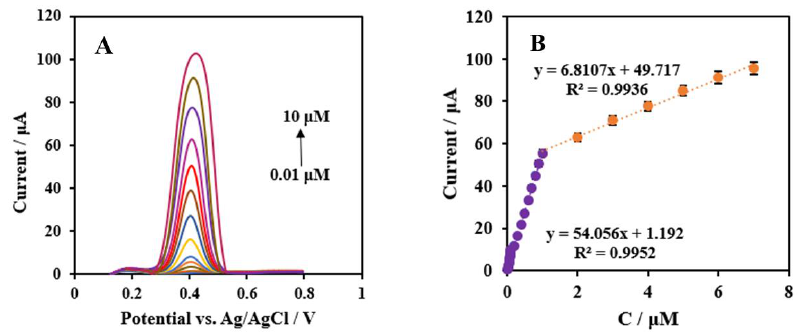
Figure 10. ( A ) SWV of NF/IL/CMC-MWCNTs/GCE responding to different concentrations of rutin. ( B ) Plot of anodic-peak current vs. rutin concentrations.